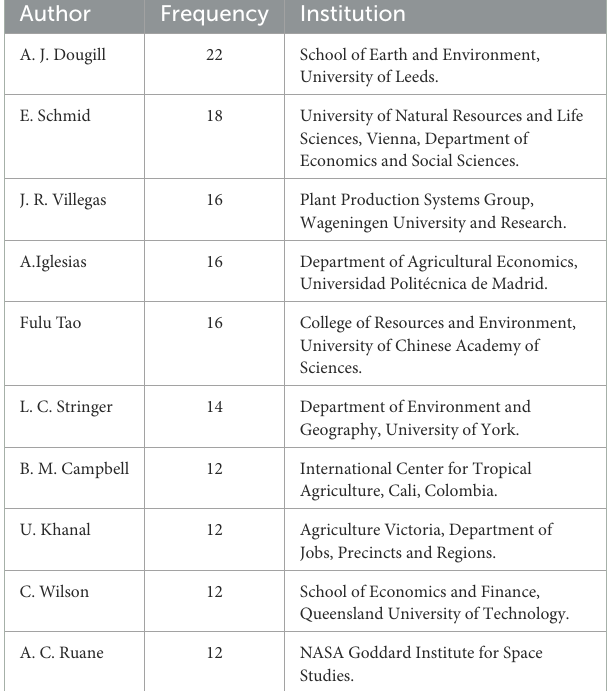
TABLE 3 Top 10 authors based on